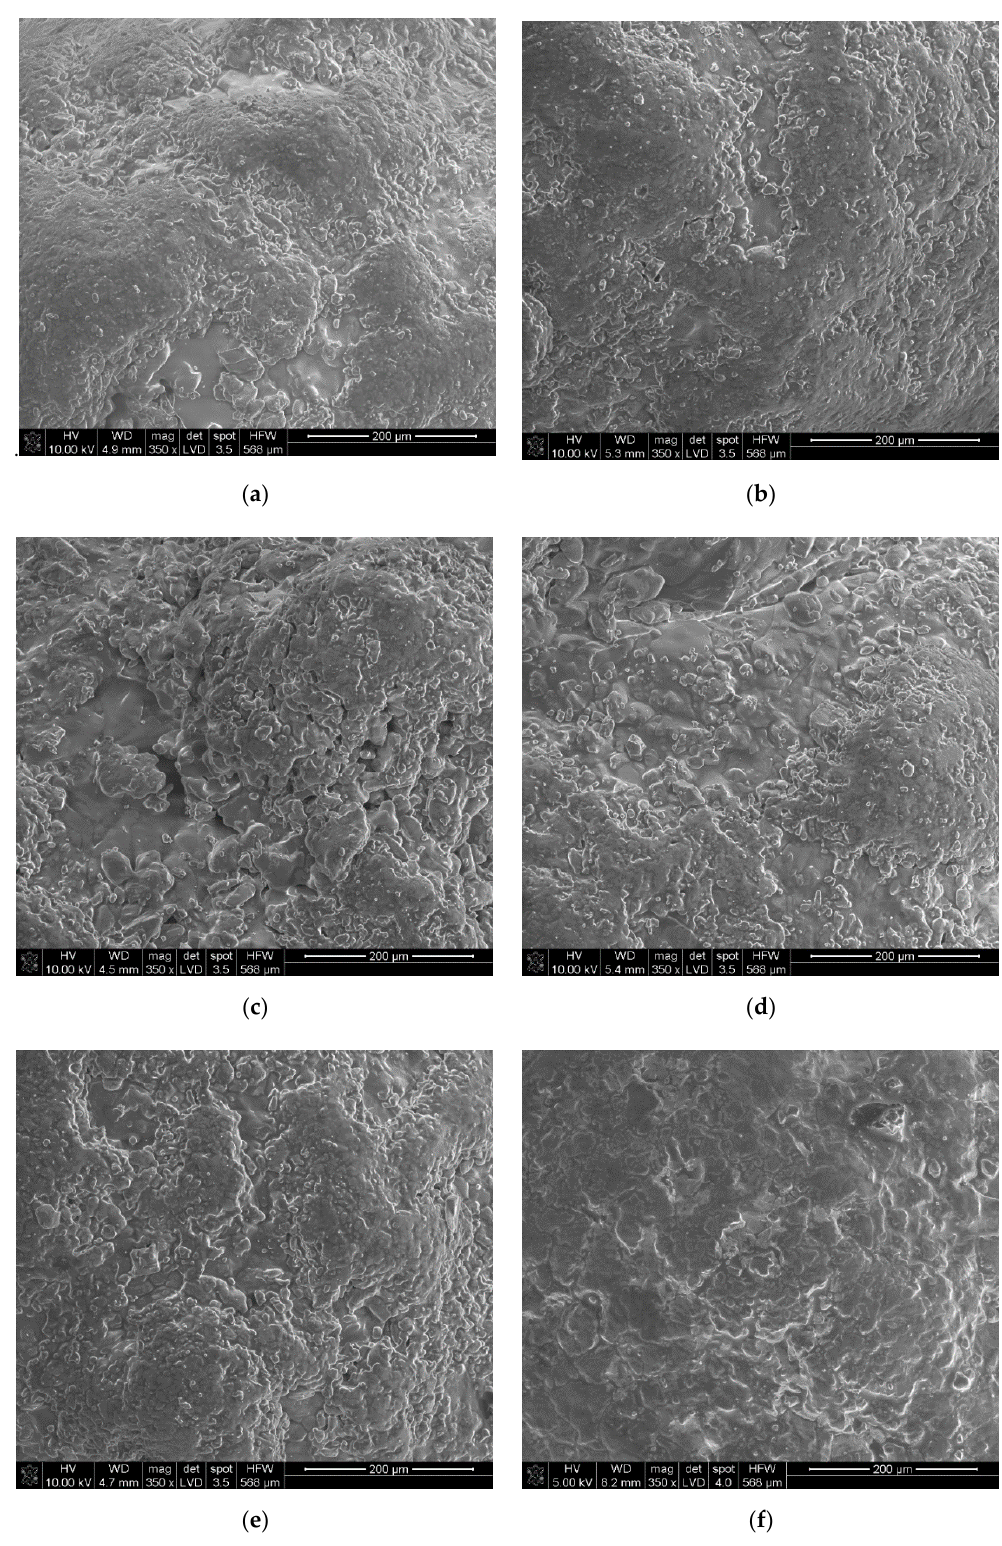
Figure 3. The results of an SEM analysis for the ANFO obtained by mixing with oil: ( a ) P1, ( b ) P2, ( c ) P3, ( d ) P4, ( e ) P5, and ( f ) P6.